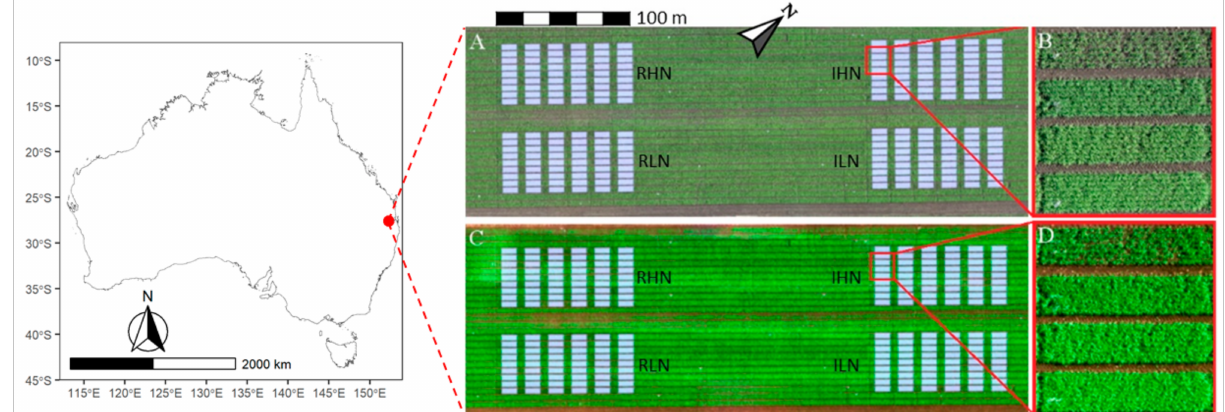
Figure 1. The location ( left ) and layout ( right ) of the wheat field trial. The layout is presented using ortho-mosaics, reconstructed from visible ( A , B ) and multi-spectral images ( C , D ) captured on 30 June 2016 (40 days after sowing). The white boxes are the segmented plots and trimmed along the four edges (10% for the east, north, and south sides, 25% for the west side). The trial was divided into four management blocks, including irrigation and high nitrogen (IHN), irrigation and low nitrogen (ILN), rainfed and high nitrogen (RHN), and rainfed and low nitrogen